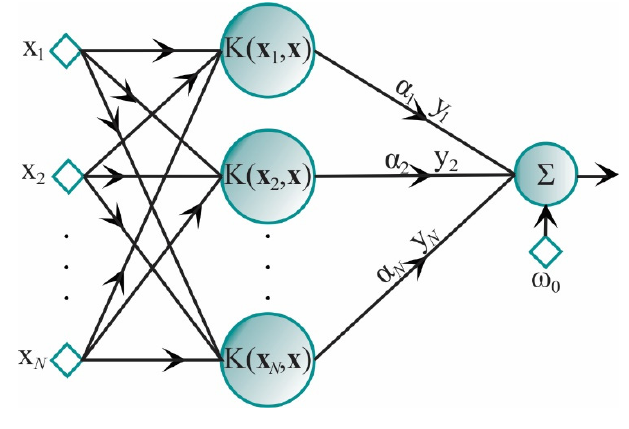
Figure 1. SVM architecture.